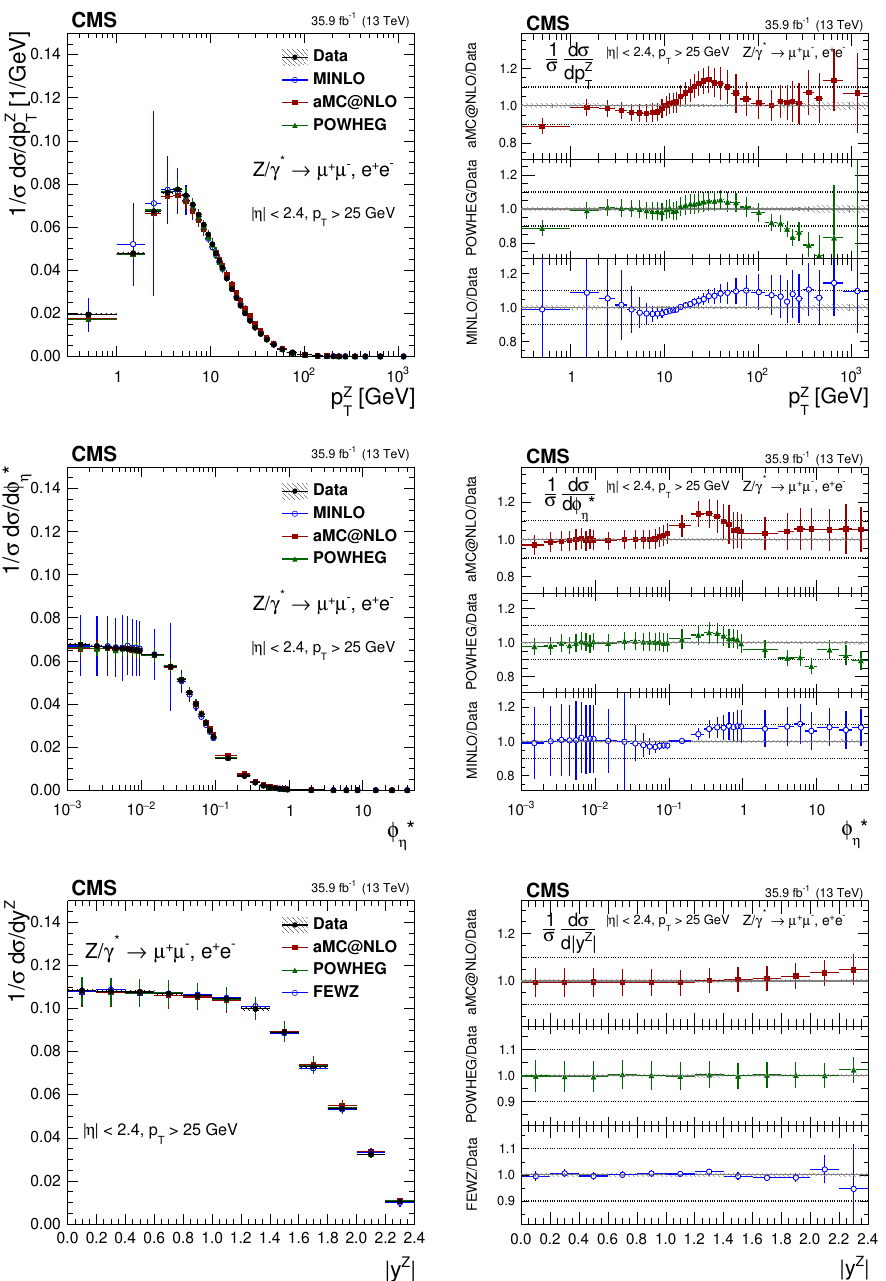
Figure 14 . The measured normalized cross sections (left) in bins of p Z (upper), (cid:30) (cid:3) (middle), (cid:17) T and j y Z j (lower) for the combined measurement. The ratios of the predictions to the data are also shown (right). The shaded bands around the data points (black) correspond to the total experimental uncertainty. The p Z and (cid:30) (cid:3) measurements are compared to the predictions with (cid:17) T MadGraph 5 a mc@nlo (square red markers), powheg (green triangles), and powheg - MINLO (blue circles). The j y Z j measurement is compared to the predictions with MadGraph 5 a mc@nlo (square red markers), powheg (green triangles), and fewz (blue circles). The error bars around the predictions correspond to the combined statistical, PDF, and scale